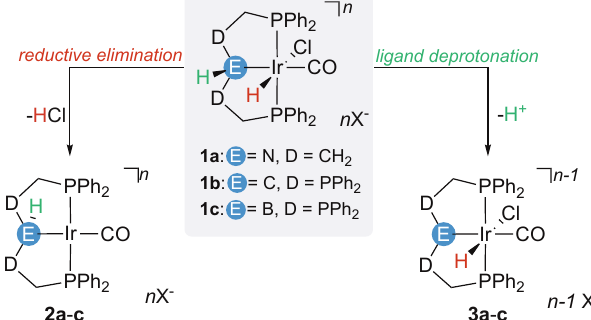
Figure 2. Cooperative ligand site vs. redox reactivity—principle reaction pathways of octahedral iridium(III) complexes 1a – 1c towards base ( n = +, 2+). X − = Cl − ( a , b ), Br − ( c